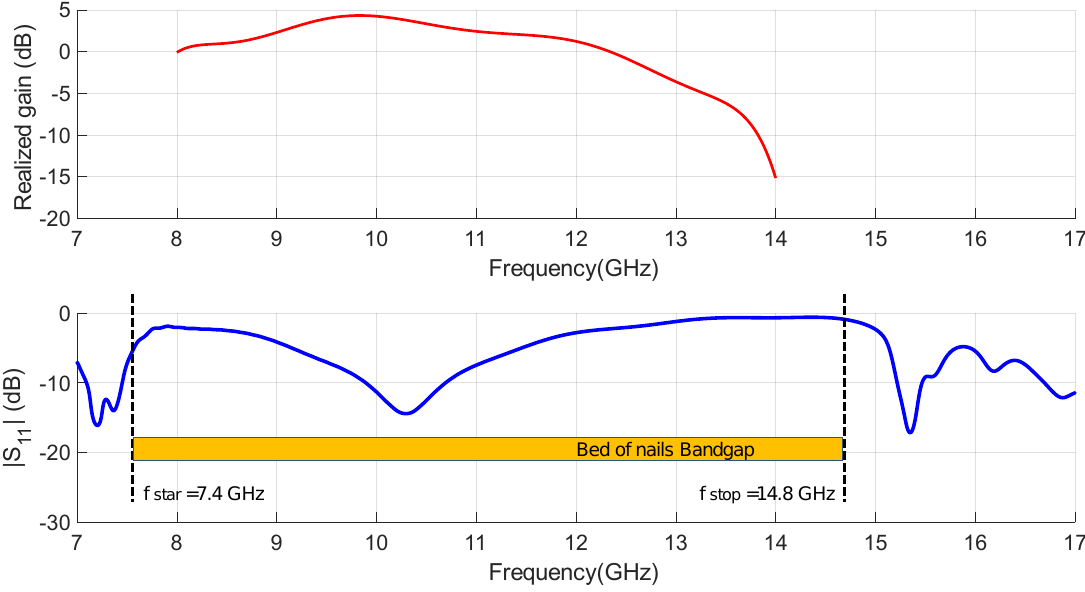
Figure 8. Simulated | S 11 | and realized gain (at broadside) of the reference slot antenna in IM-GWG (slx = 14.8 mm, sly = 3.25 mm, dipx = 13.8 mm and dipy = 2